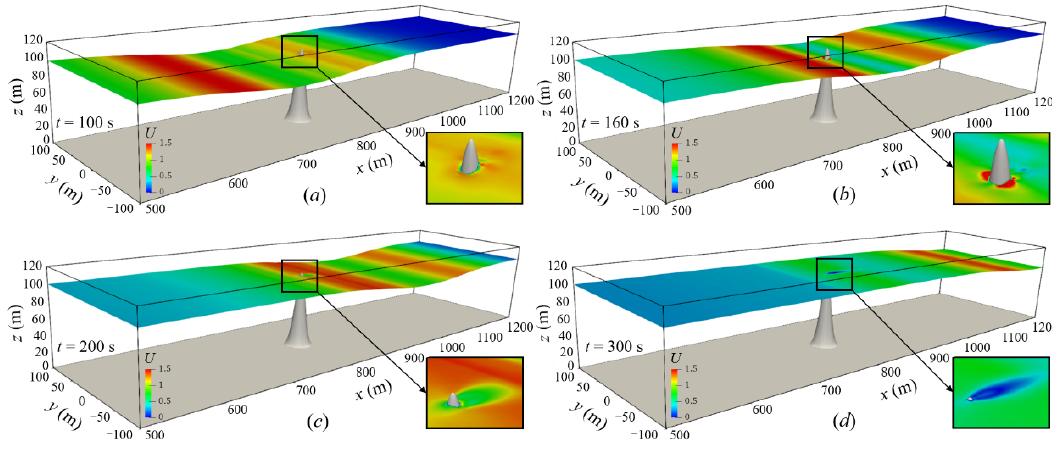
Figure 18. Temporal and spatial variation in the ISWs propagating over a 3D Gaussian ridge.